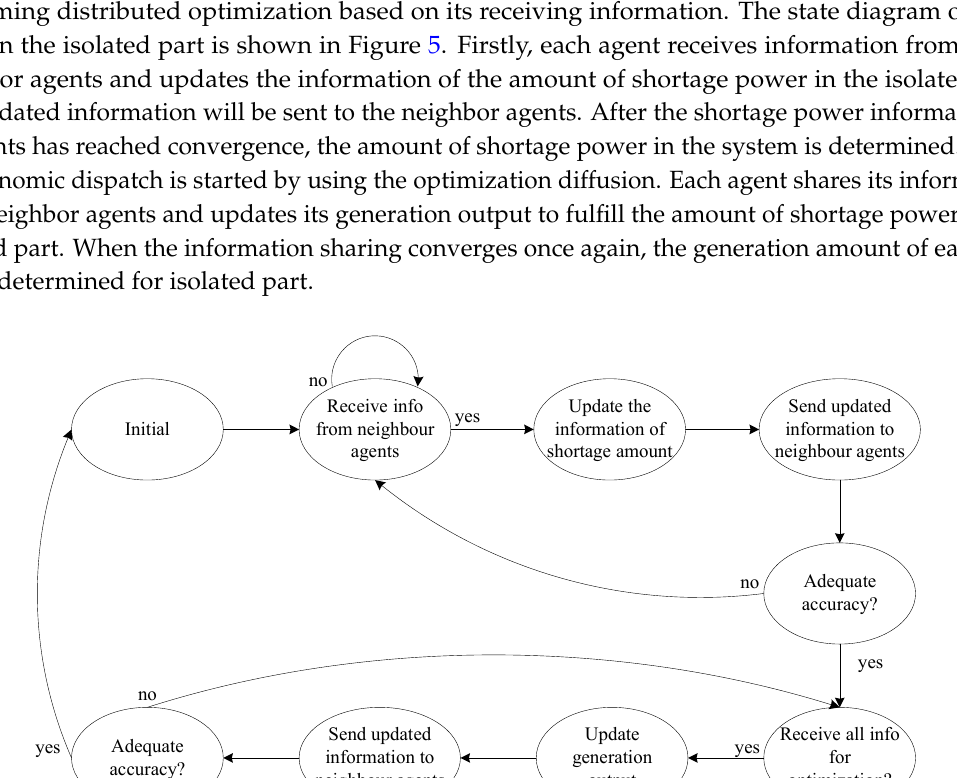
Figure 5. State diagram of each agent in isolated part.